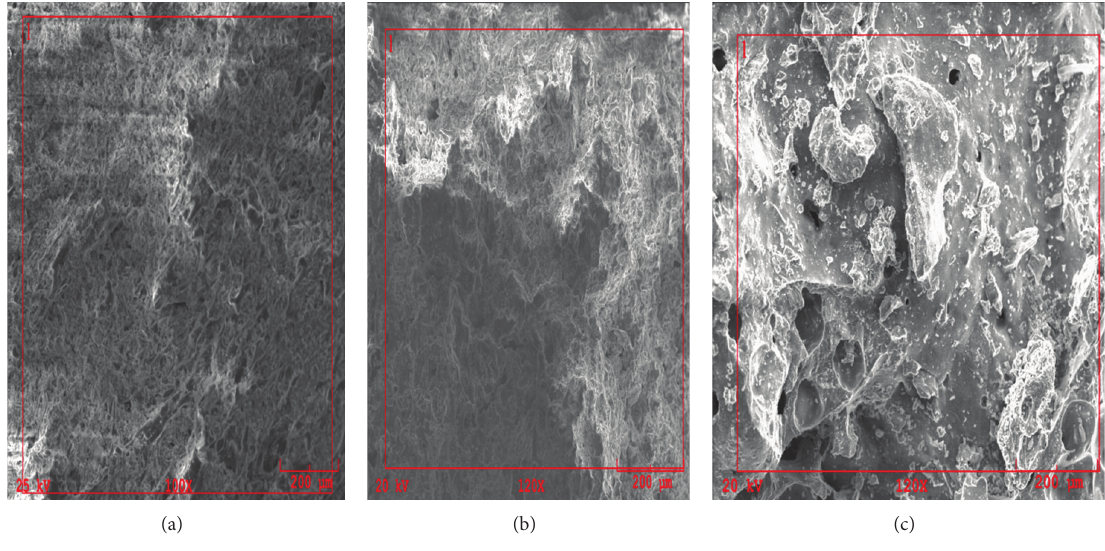
Figure 1: SEM images: (a) pumice, (b) PTS, and (c)